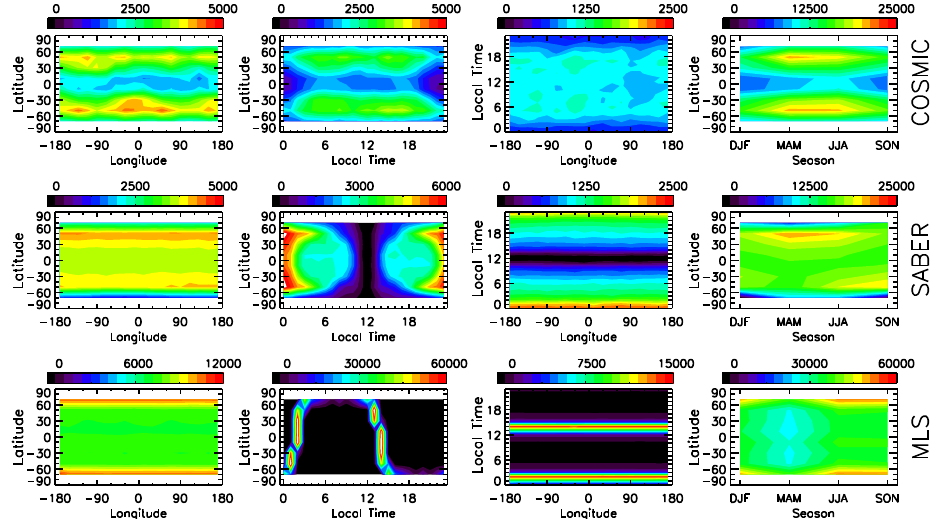
Fig. 1. The global distribution of number of temperature profiles from COSMIC (top row), SABER (middle row) and MLS (bottom row), with respect to space, time and